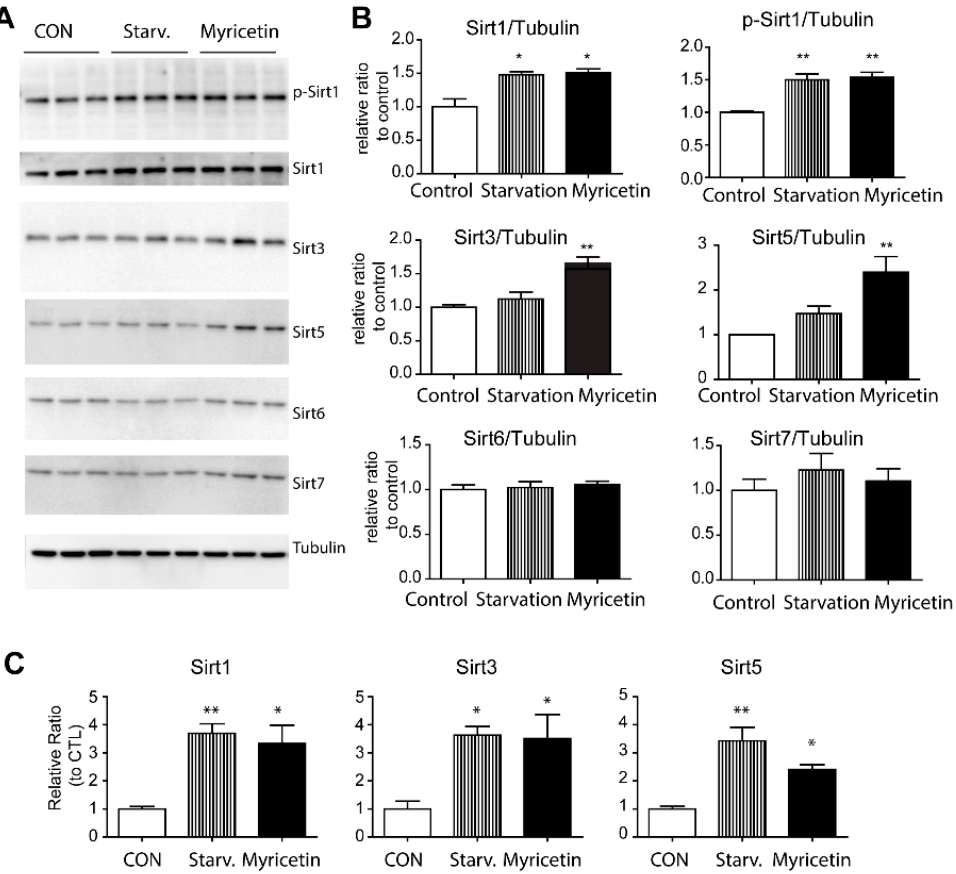
Figure 4. Effect of myricetin on mitochondrial sirtuin expression in cultured adipocytes. ( A , B ) Immunoblot analysis and quantification of sirtuins in adipocytes differentiated from C3H10T1/2 cells treated with vehicle controls (CON), starvation medium and myricetin (10 µ M) for 24 h. ( C ) qPCR analysis of sirtuins in adipocytes differentiated from C3H10T1/2 treated with myricetin (10 µ M) for 24 h ( n = 3, means ± SEM, * p < 0.05, ** p < 0.01)